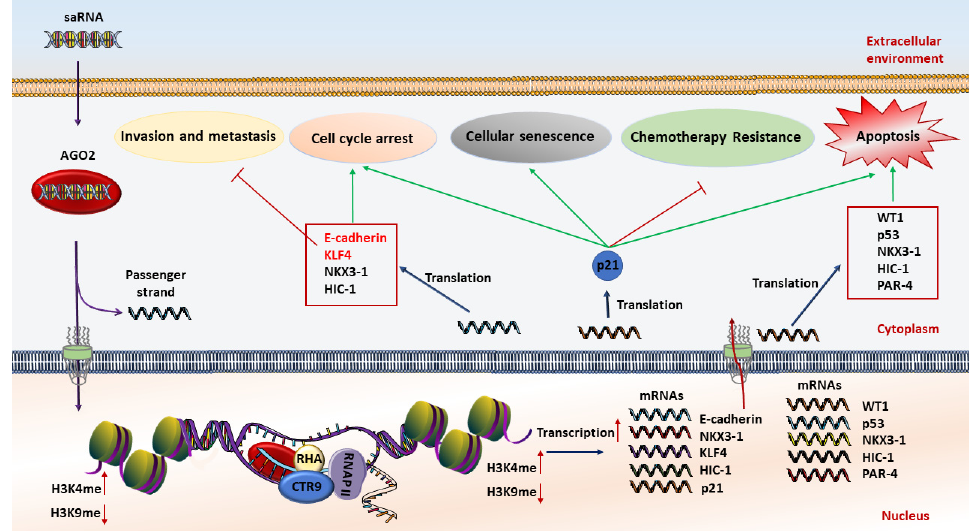
Figure 1. Schematic illustration of the anticancer mechanism of saRNA (small activating RNA)-based therapeutics. At first, saRNAs are loaded on the AGO2 protein. Then AGO2 separates the passenger strand. After that, the complex of saRNA guide strand and AGO2 cross the nuclear and interact with promoter sequences of interested genes to increase transcription by methylation of H3K4 and/or demethylation of H3K9. The expression level of tumor suppressor genes is restored, resulting in induction of apoptosis, chemoresistance reversal, inhibition of invasion and metastasis, cell cycle arrest, and cellular senescence.